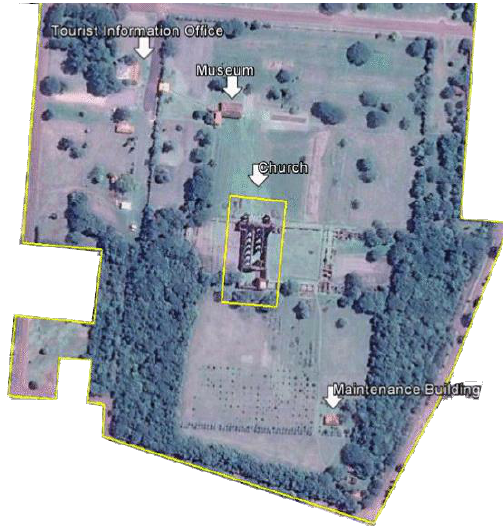
Figure 2 – Study Area: São Miguel Arcanjo Park. (Font: Adapted Google Earth)